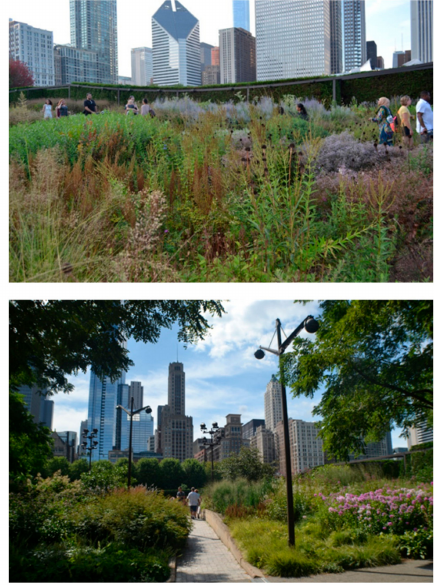
Figure 6. Among the most attractive features in Millennium Park is Lurie Garden. Located near the southern edge of the park, Lurie Garden is a spectacular five-acre “prairie oasis”. The study participants liked the garden immensely for o ff ering a respite from urban life and engaging them in an immersive nature experience that allows for a temporary “mental” escape from the nearby “urban jungle”. The garden hosts indigenous vegetation. Its organic and natural appearance also evokes a complementing contrast with the orderly building environment dominated by